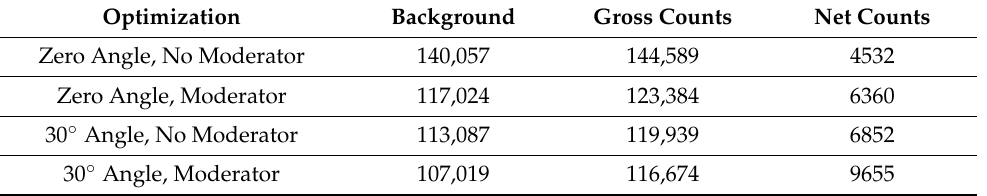
Table 1. Optimizations of Genie 16 setup in order to obtain the best net counts for a pure Ti sam- ple.